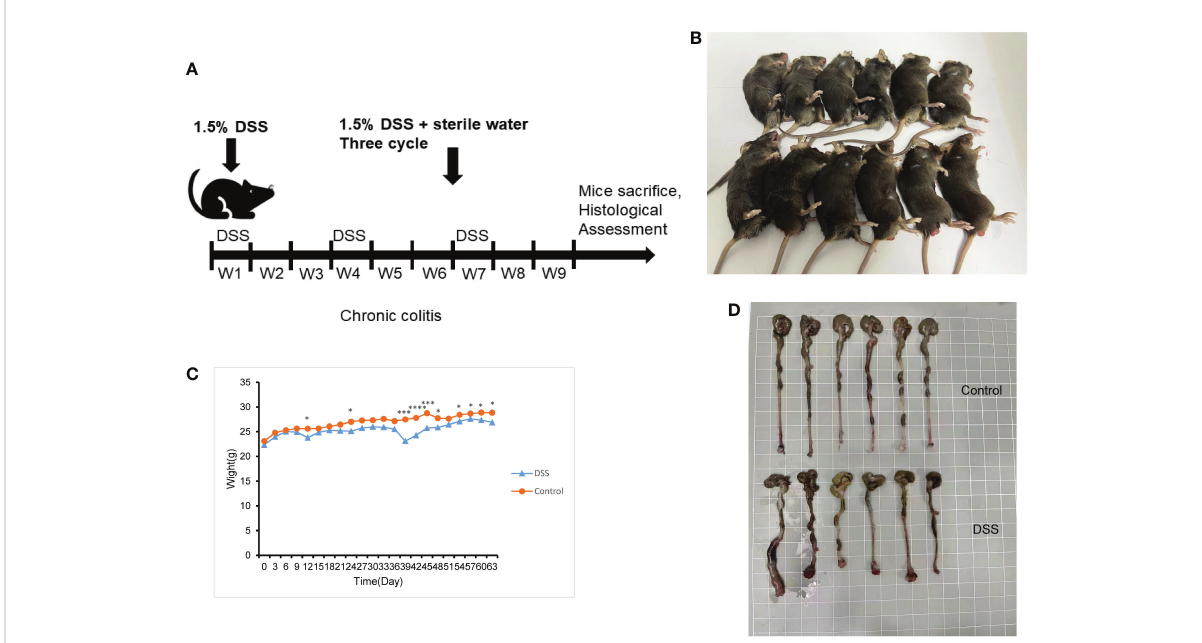
FIGURE 8 The construction of the in fl ammatory bowel disease (IBD) model. (A) Flow chart for mice feeding. (B) Irregular perianal prolapse in mice. (C) Body weight changes in mice. (D) Comparison of the length of colon. * P < 0.05, *** P < 0.001, **** P < 0.0001. .